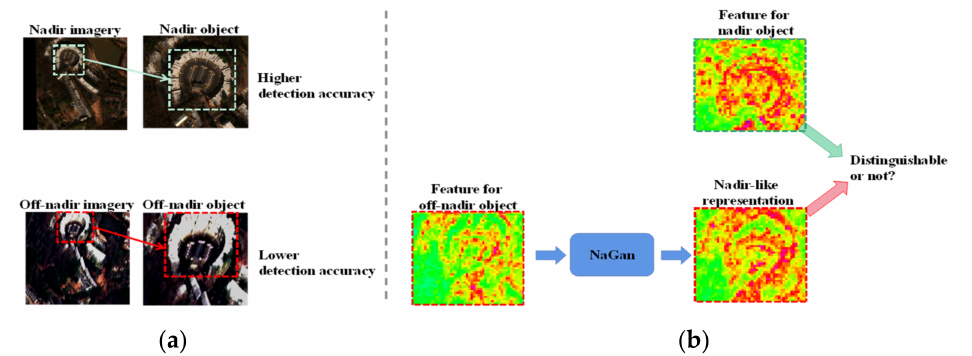
Figure 1. Difficulty illustration of object detection on off-nadir image. ( a ) The nadir object is different from the off-nadir object with respect to appearance due to viewpoint differences and imaging uncertainties, and features of nadir and off-nadir objects are exhibited differently by traditional detectors, which impacts detection performances. ( b ) NaGAN aims to generate the nadir-like representation for the off-nadir object, and a higher detection accuracy is gained on off-nadir images. The second difficulty lies in the label accuracy. To save the labeling cost, only nadir images are labeled, and labels of off-nadir images are usually copied from the nadir